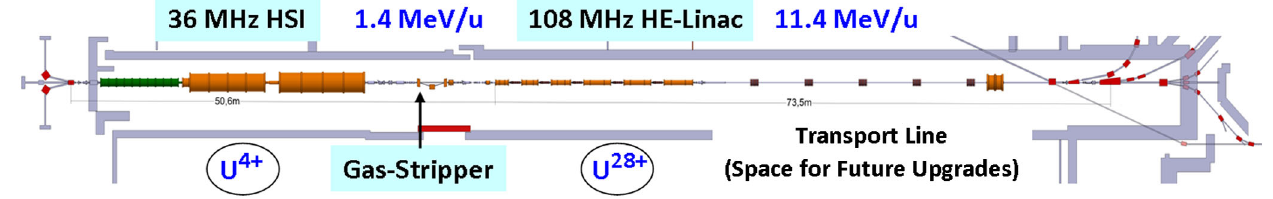
FIG. 1. Scheme of the proposed new GSI high energy heavy – ion linac.